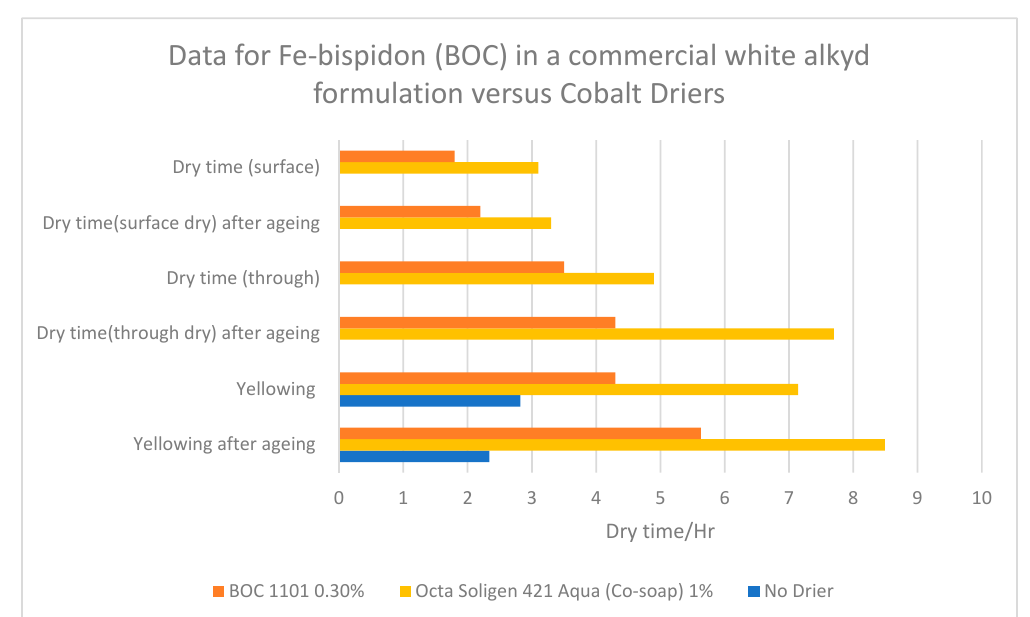
Figure 5. Data from a commercial resin comparing Borchi® OxyCoat (BOC) 1101 with a cobalt-siccative. Note that the resin does not dry without a catalyst (no siccative). BOC 1101 is a 1% solution of Fe-bispidon catalyst in water. Octa Soligen 421 is a mixture of cobalt, zinc, and zirconium carboxylates in water-dispersible oil.